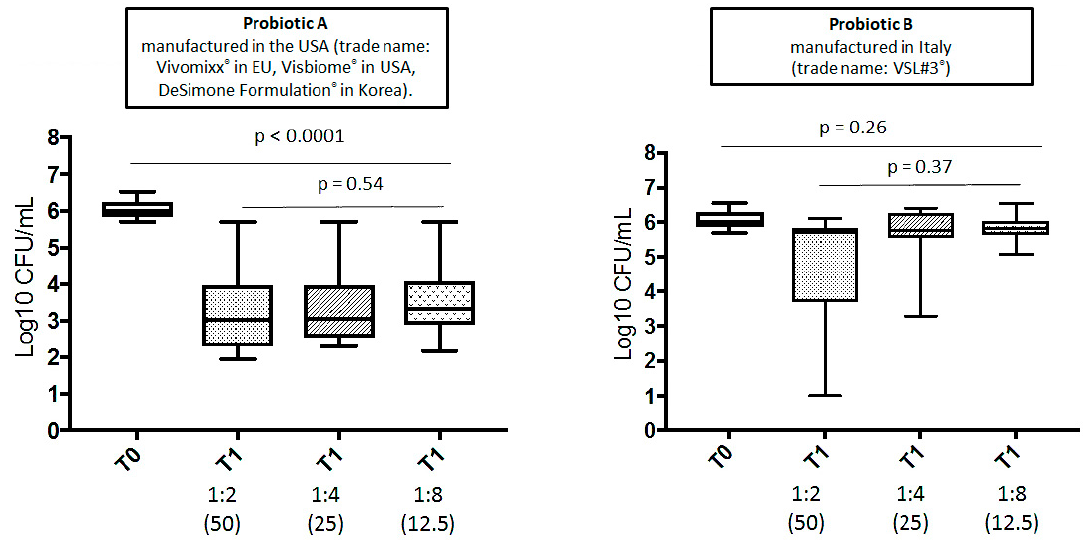
Figure 2. Candia albicans growth inhibition effect observed at different dilutions of fecal water in Vivomixx and VSL#3 supplemented participants.